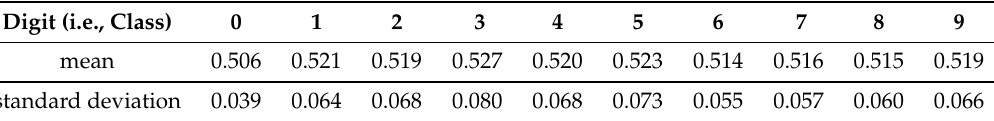
Table 1. Per-class mean and standard deviation of the max2 uncertainty scores among the correctly classified samples, acquired from feeding the validation